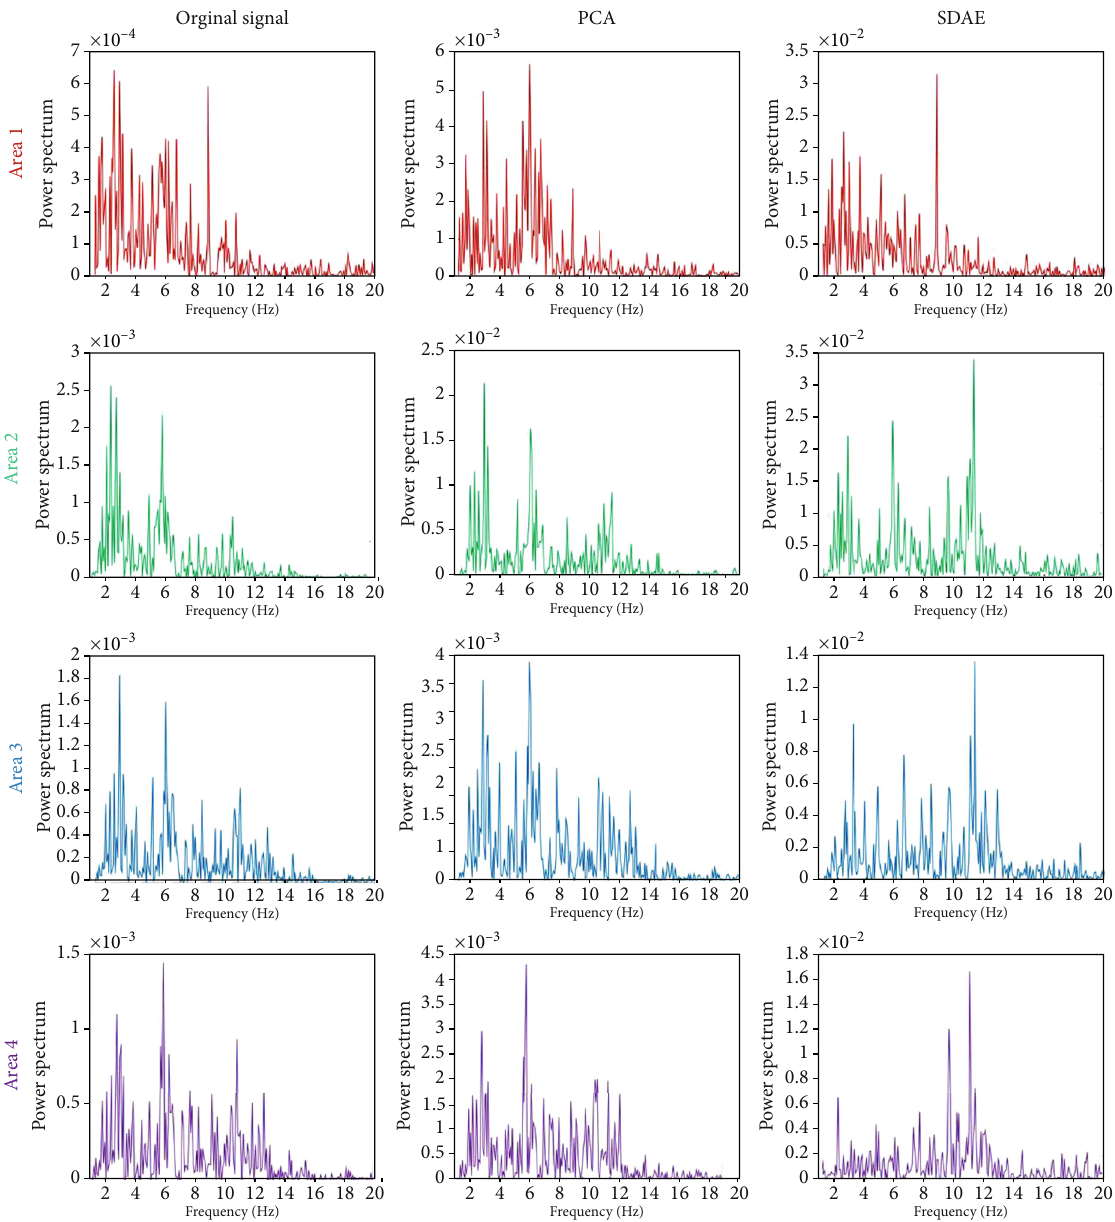
Figure 5: The power spectrum of the average original signal, the extracted feature by PCA, and the extracted feature by SDAE from four areas on awake